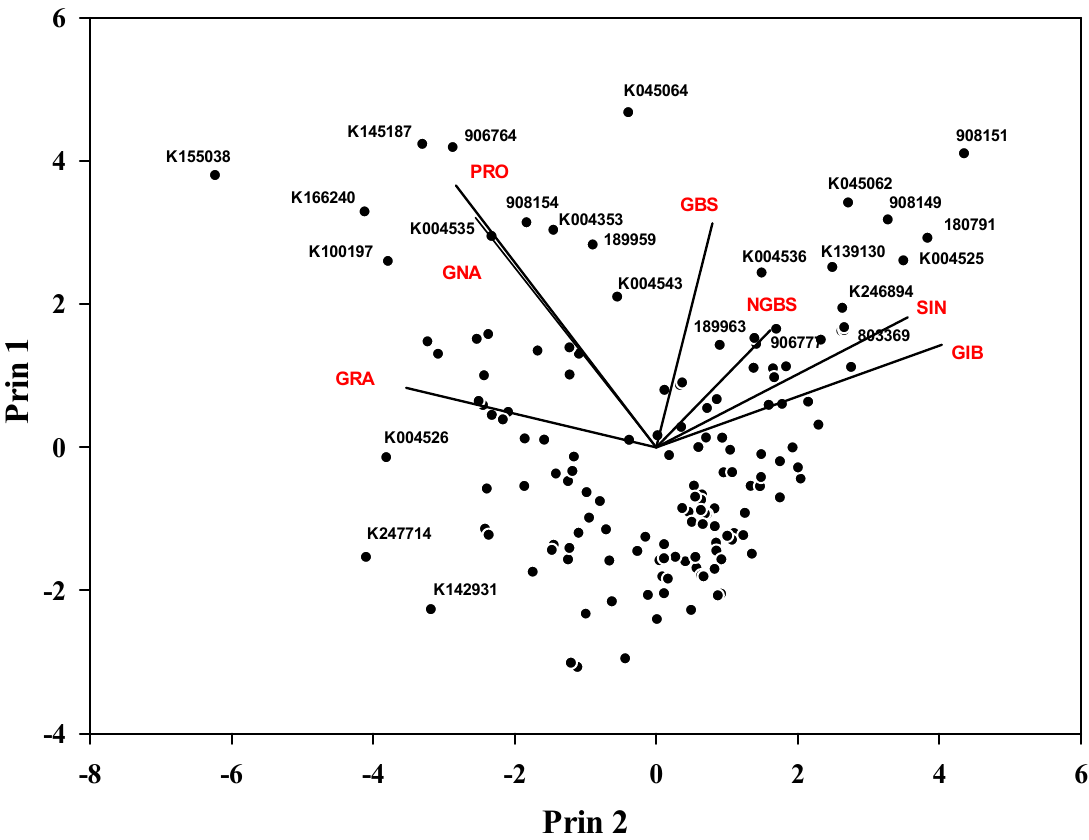
Figure 4. Principal component analysis (PCA) of individual major GSLs. GRA: glucoraphanin; GNA: gluconapin; PRO: progoitrin; GBS: glucobrassicin; NGBS: neoglucobrassicin; SIN: sinigrin; GIB: